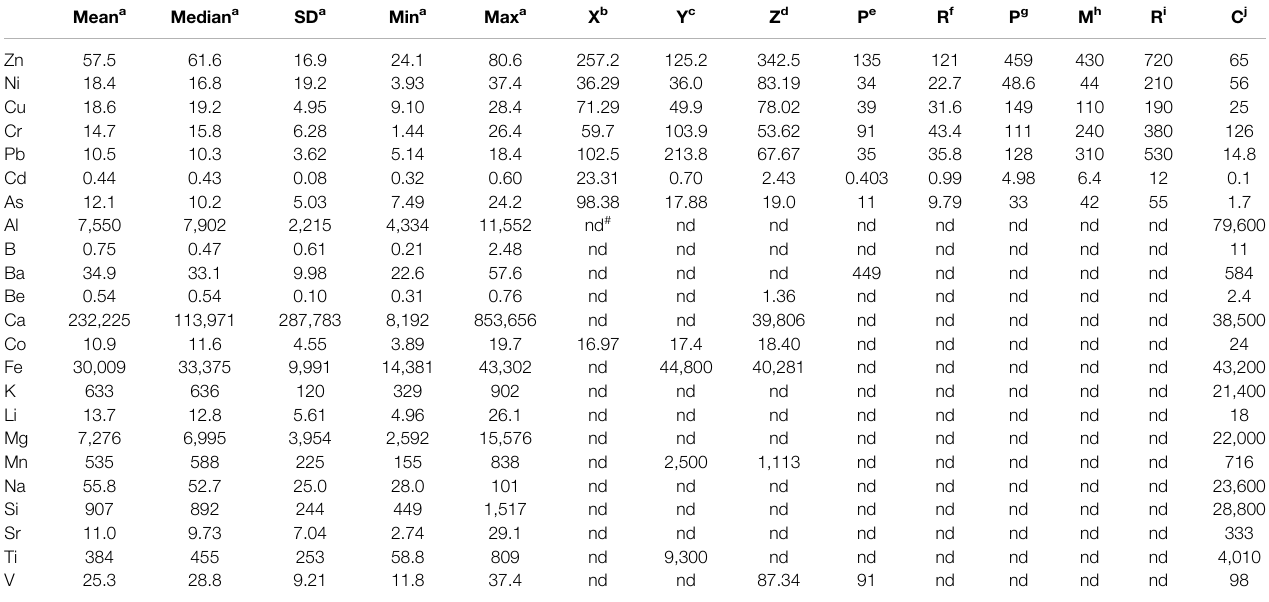
TABLE 5 | Descriptive statistics for total element content (mg kg − 1 ) in